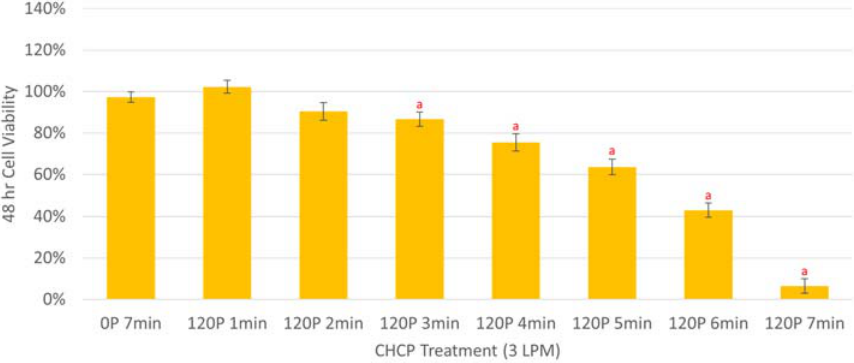
Figure 2. Bar graph showing the cell viability of 94T778 cells 48-h post-CHCP treatment compared to mock controls. Liposarcoma cells were seeded in 12-well plates at a concentration of 2.5 × 10 4 cells/well and treated with 3 LPM at 120 P for 1–7 min. Helium alone (0 P) did not significantly impact cell viability. All treatment durations lasting at least 3 min significantly reduced viability of 94T778 cells compared to mock controls. Statistical significance for CHCP versus mock controls ( a p ≤ 0.05) were considered.